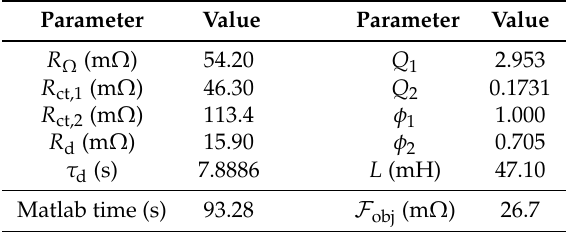
Table 5. Experimental dataset B. Identification results in normal operative conditions with Dhirde